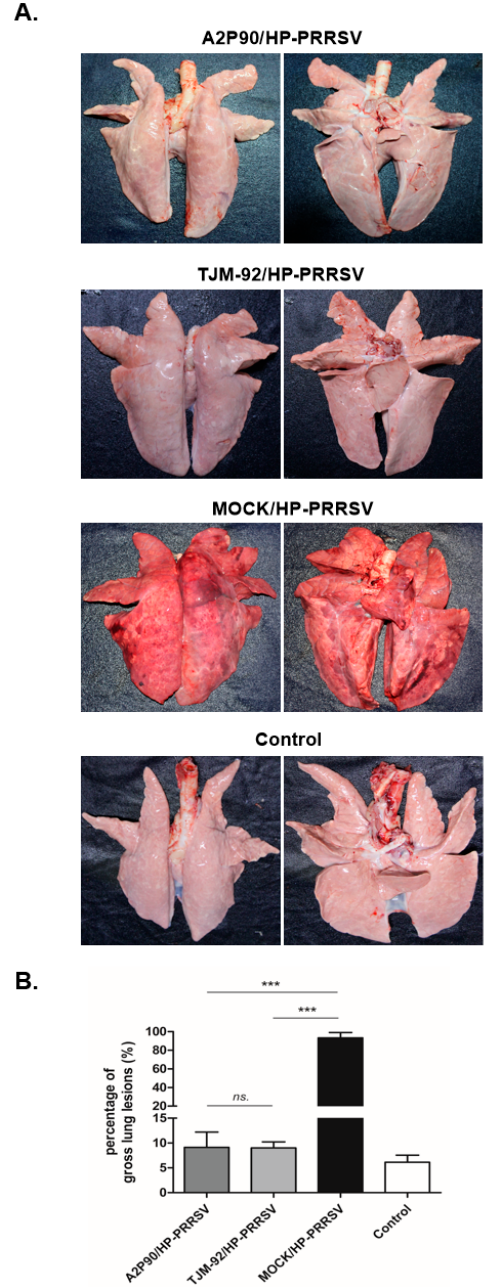
Figure 3. PRRSV-A2MC2-P90 vaccination prevented development of pathological lung lesions after HP-PRRSV challenge in vivo. ( A ). A total of 16 piglets were randomly divided into 4 groups ( n = 4) that included the negative control group, A2MC2-P90-vaccinated group (A2P90/HP-PRRSV), TJM F92-vaccinated group (TJM-92/HP-PRRSV) and non-vaccinated HP-PRRSV-challenged group (MOCK/HP-PRRSV). Representative ventral and dorsal lung images from each group were captured immediately after piglets were autopsied at 21 dpc or at time of death if before 21 dpc. ( B ). Gross pathological changes of all animals in each group were quantified using a scoring system based on a 100-point scale. Data are expressed as the mean ± SD and were subjected to a Student’s t -test. Significant differences between indicated groups were marked with *** ( p < 0.001) or NS (not significant).